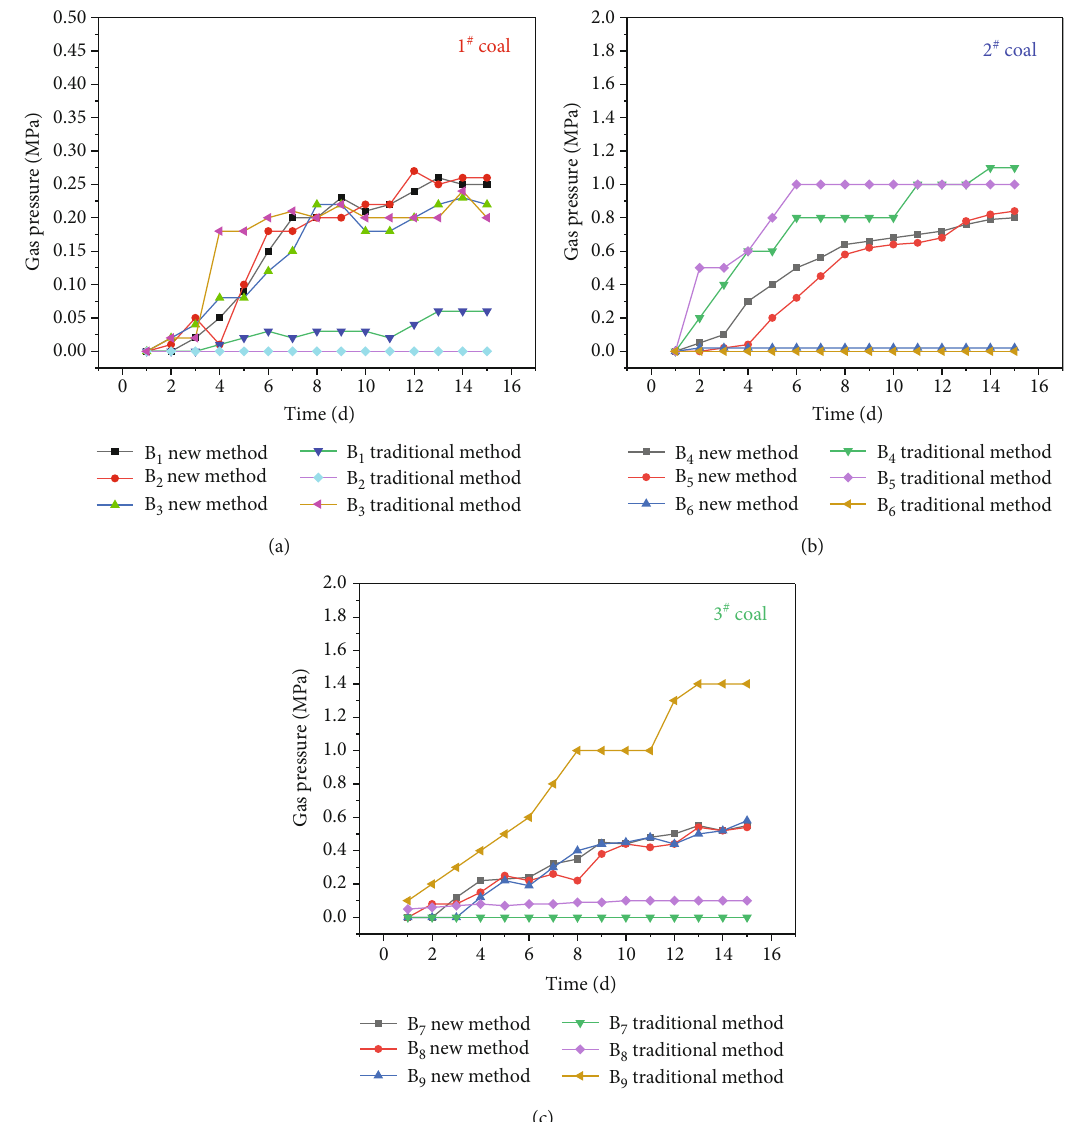
Figure 11: Gas pressure measurements obtained using new method and traditional method.